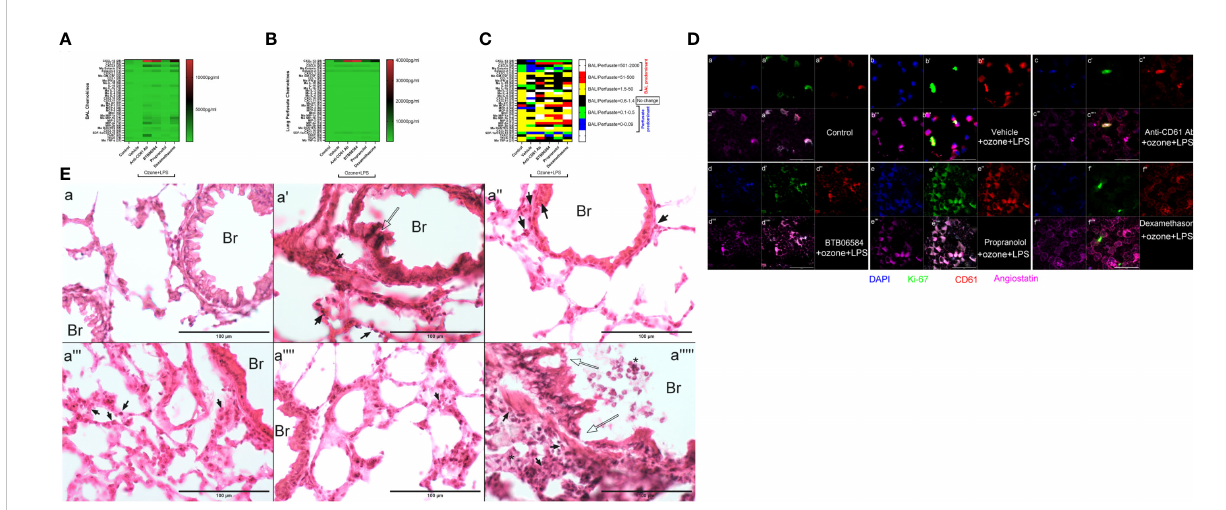
FIGURE 2 Chemokine, molecular and histology. (A) Bronchoalveolar lavage (BAL) fl uid 33-plex chemokine analysis expressed as pg/ml in heat map, (B) Lung vascular perfusate 33-plex chemokine analysis expressed as pg/ml in heat map and (C) BAL/vascular perfusate ratio of 33 chemokines across the six groups: control, and 5 treatment groups namely vehicle, CD61 blocking (anti-CD61) antibody, BTB06584, propranolol and dexamethasone treatments. For magnetic bead-based immunoassay (Bio-rad Laboratories Ltd., CA, US), the following chemokines were analyzed: CXCL13 (B- lymphocyte chemoattractant), CCL27 (IL-11 R-alpha-locus chemokine (ILC)), CXCL5 (epithelial-derived neutrophil-activating peptide 78 (ENA-78)), CCL-11 (eotaxin-1), eotaxin-2 (CCL-24), CX3CL1 (fractalkine), GM-CSF (CSF-2), CCL1, IFN g (interferon gamma), IL-10 (interleukin-10), IL-16 (interleukin-16), IL-1 b (interleukin-1 beta), IL-2 (interleukin-2), IL-4 (interleukin-4), IL-6 (interleukin-6), CXCL-10 (interferon gamma-induced protein 10 (IP-10)), CXCL11 (Interferon-gamma-inducible protein 9 (IP-9)), KC (keratinocyte chemoattractant), MCP-1 (monocyte chemoattractant protein-1), MCP-3 (monocyte chemoattractant protein-3), MCP-5 (monocyte chemoattractant protein-5), MDC (macrophage-derived chemokine (CCL22)), MIP-1 a (macrophage in fl ammatory protein-1 alpha), MIP-1 b (macrophage in fl ammatory protein-1 beta), MIP-2 (macrophage in fl ammatory protein- 2), MIP-3 a (macrophage in fl ammatory protein-3 alpha), MIP-3 b (macrophage in fl ammatory protein-3 beta), RANTES (regulated on activation, normal T cell expressed and secreted (CCL5)), CXCL-16, CXCL-12/SDF-1alpha (stromal cell-derived factor 1), TARC (thymus and activation